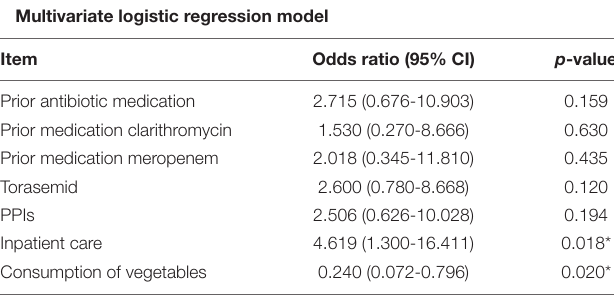
TABLE 2 | Results of the multivariate logistic regression model. Multivariate logistic regression